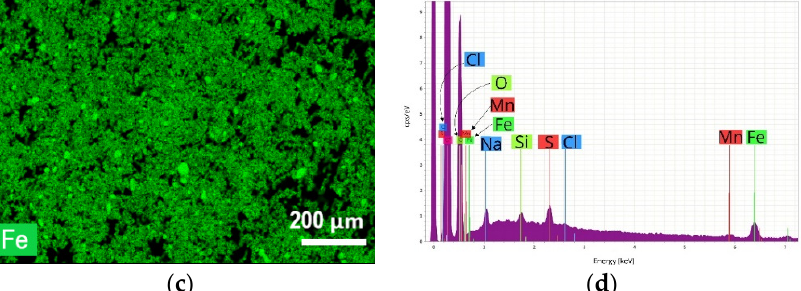
Figure 3. Scanning Electron Microscopy (SEM) images of magnetic xerogel monoliths (MXs) ( a , b ), Fe mapping analysis in MXs composites ( c ) and energy dispersive X-ray analysis (EDX) images with elemental analysis ( d ) of MXs.